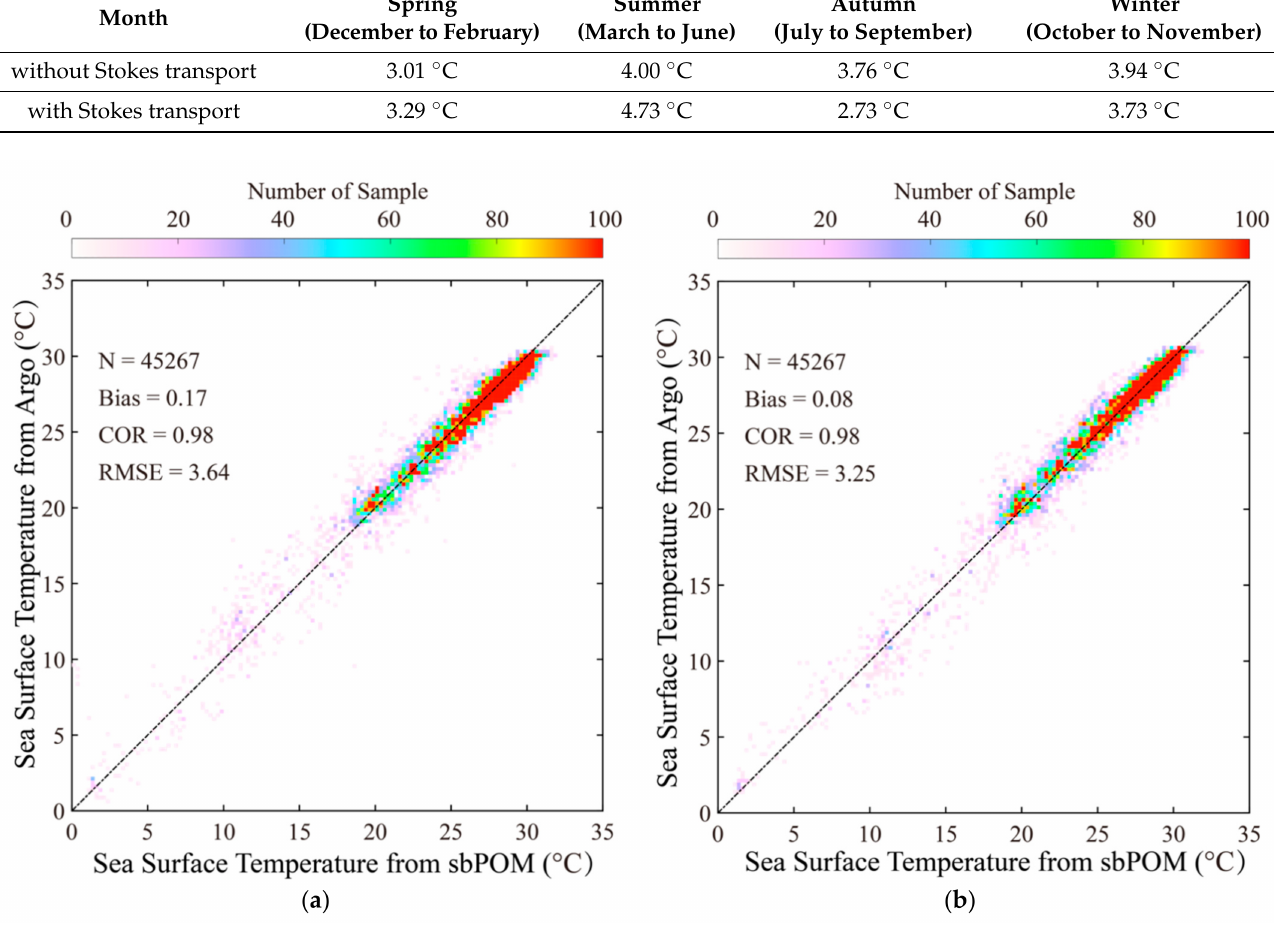
Figure 12. Comparison of sea surface temperature from Argo and the sbPOM in 2012–2015: ( a ) without Stokes transport and ( b ) with Stokes